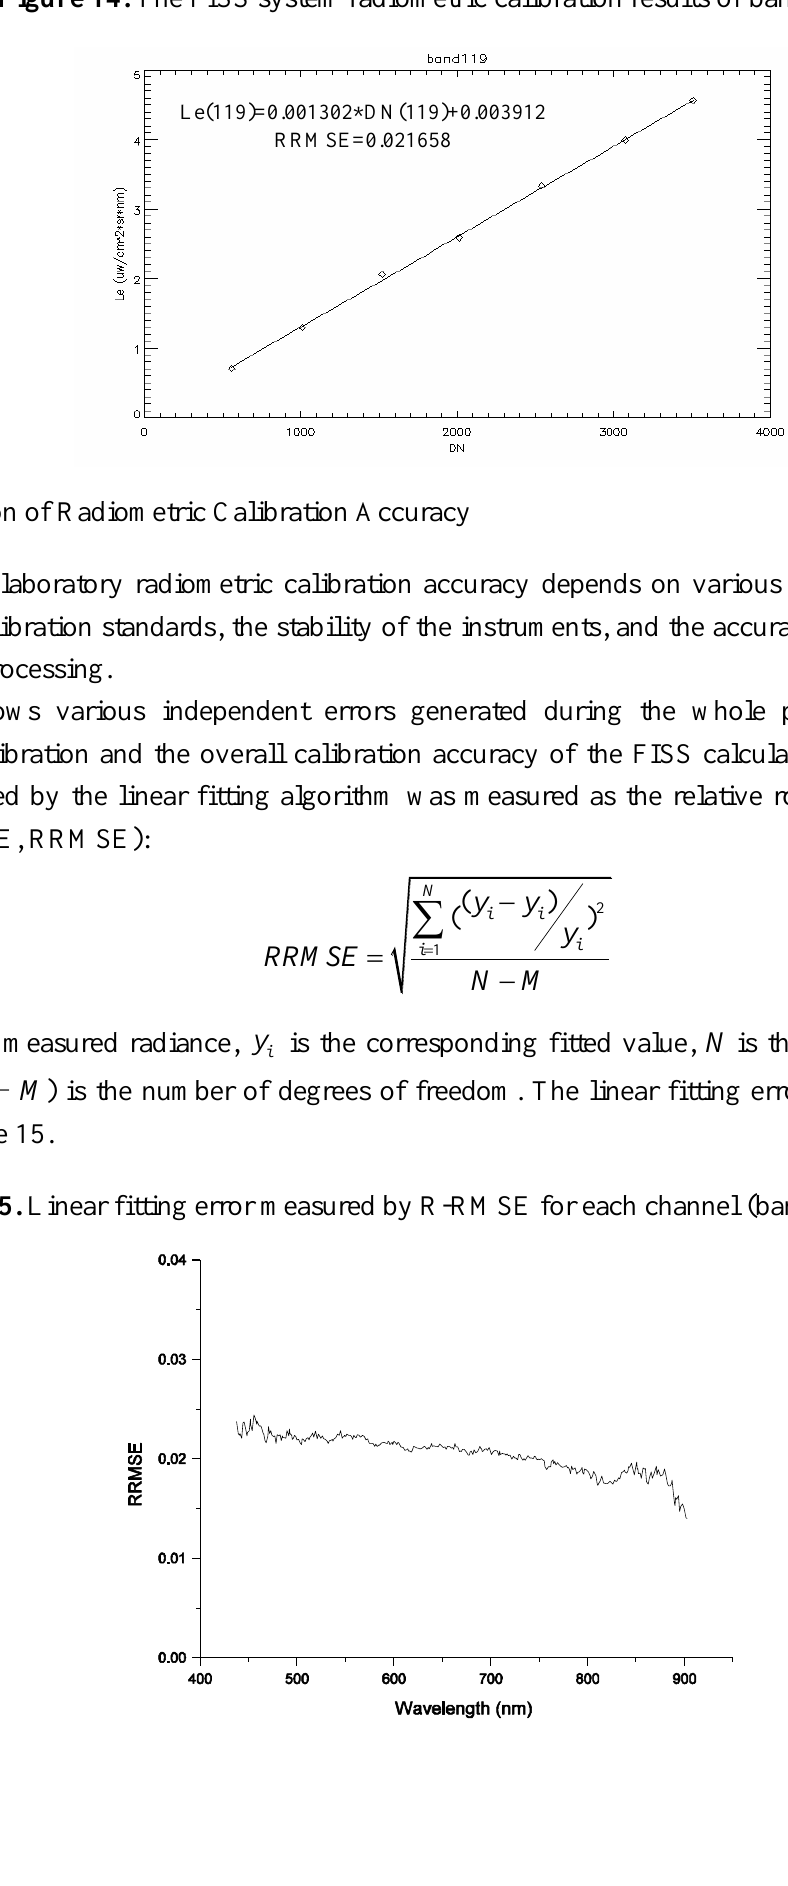
Figure 14. The FISS system radiometric calibration results of band 119.